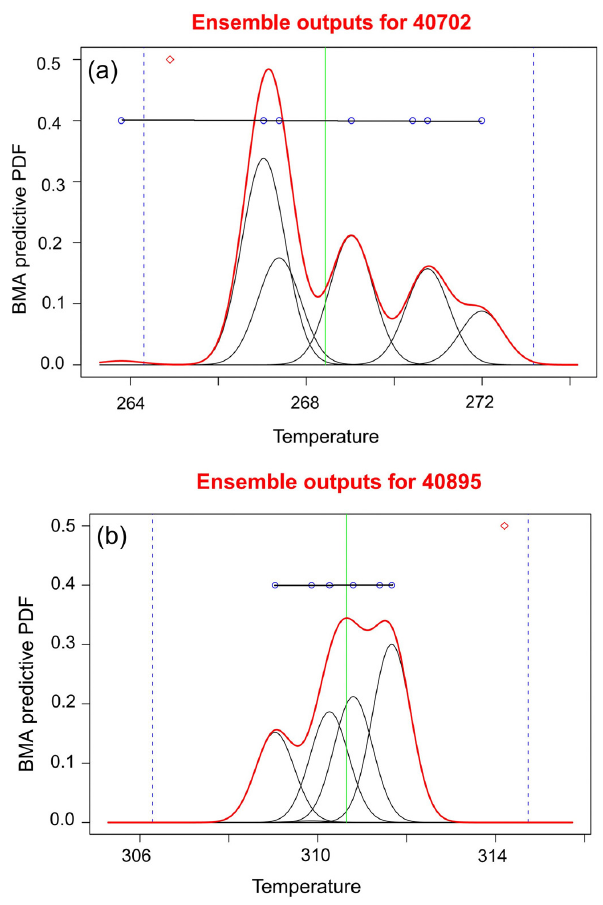
Fig. 11. Same as Fig. 7, but for (a) Jolfa on 2 January 2009 and (b) Nik-Shahr on 28 April